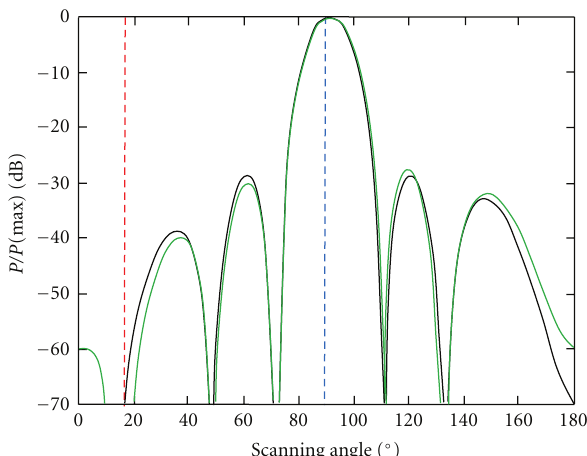
Figure 18: The beam pattern of the antenna array with the 15 degrees of interference.